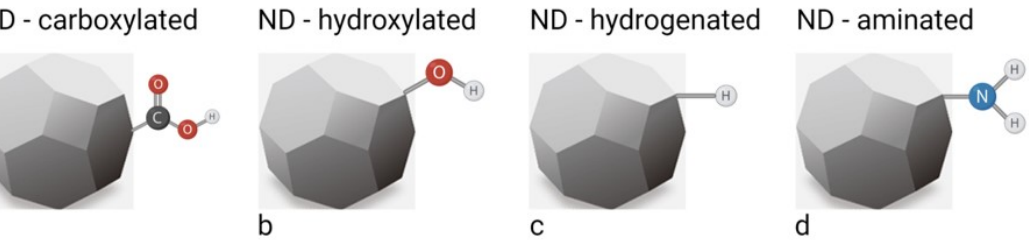
Figure 1. Basic formation of uniform surface constituents on NDs by carboxylation ( a ), hydroxylation ( b ), hydrogenation ( c ) and amination ( d ). The actual surface constituents and their relative abundance are determined by the production methods and subsequent purification steps. The illustration was created by the authors using the BioRender app.